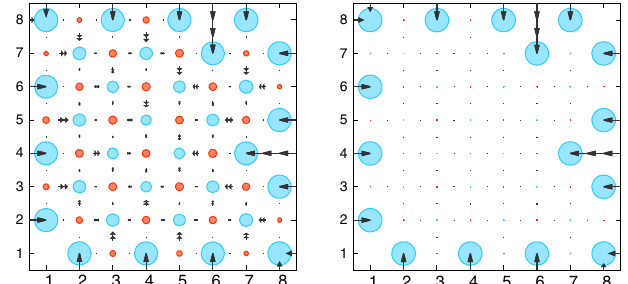
FIG. 8. Field plots from the TTN numerical simulations of 8 × 8 systems in the Q ¼ − 16 charge sector. The couplings are tuned in such a way that the system is deep in the vacuum regime (right = 2 ¼ 2 ; m ¼ 5 ) or near the critical region (left panel, panel, g 2 e = 2 ¼ 2 ; m ¼ − 1 ). Notice how the excess of charge is larger than g 2 e theallowedantimattersitesatthesurface:Thesystemhastoallocate two extra charges in the next-neighboring sites to the surface.